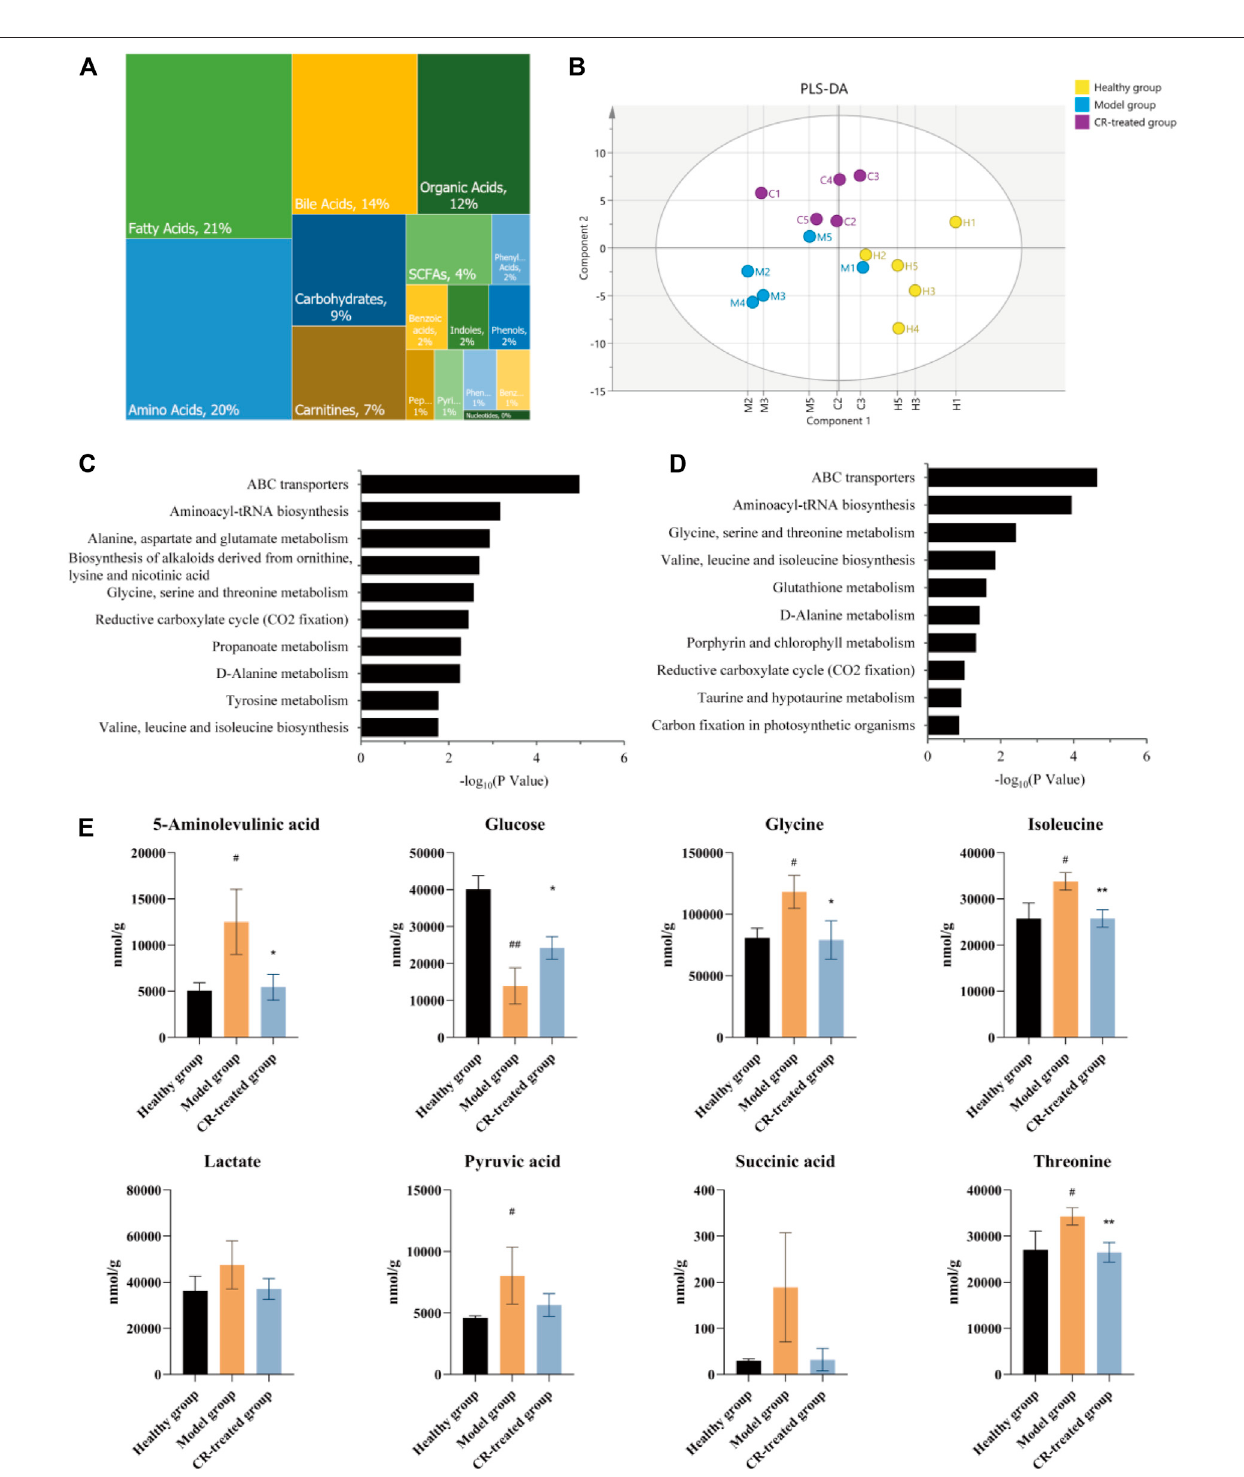
FIGURE3| Quantitative metabolomics analysis of CR. (A) Relative abundance of each metabolite class in 221 metabolites. (B) PLS-DA analysis in healthy group, model group and CR-treated group ( n = 5). (C) Analysis of KEGG pathway (model group vs. healthy group) based on quantitative metabolomics. (D) Analysis of KEGG pathway (CR-treated group vs. model group) based on quantitative metabolomics. (E) CR intervention reverses the disturbed biomarkers of glycolysis and citrate cycle in GPL animal model. The graphs show the mean ± SD in three independent experiments ( n = 5). # p < 0.05 vs Healthy group. ## p < 0.01 vs Healthy group. * p < 0.05 and ** p < 0.01 vs Model group.